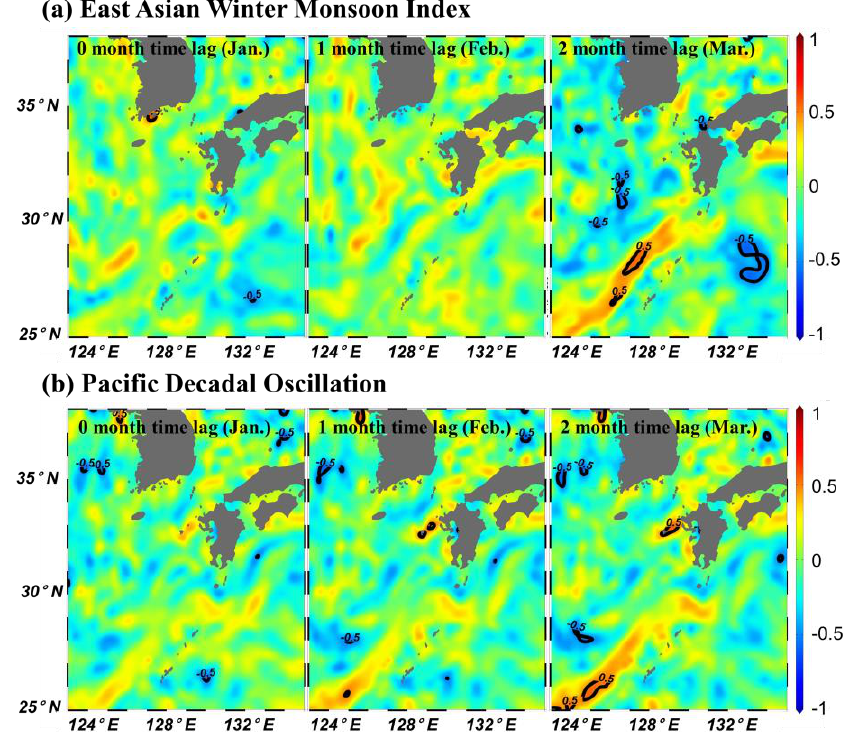
Figure 5. Horizontal distribution of the correlation coefficient between the geostrophic surface current velocity in January: ( a ) East Asian Winter Monsoon Index (January–March), and ( b ) Pacific Decadal Oscillation Index (January–March). Black lines represent significant levels: p < 0.01).